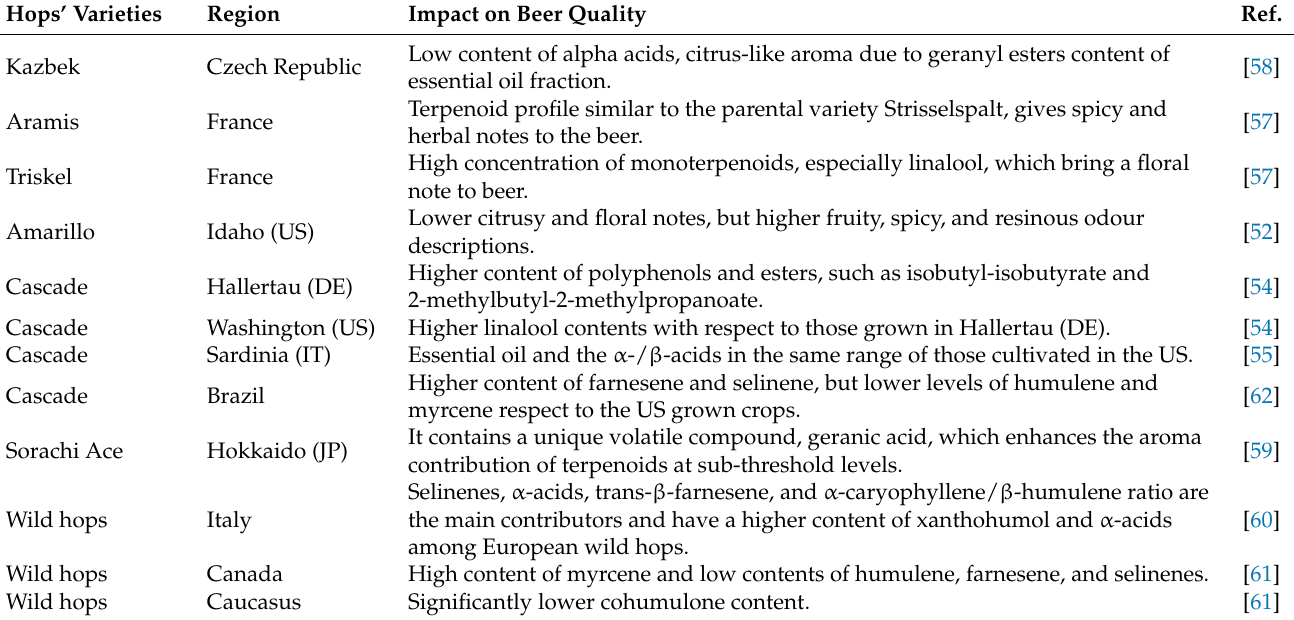
Table 2. Cultivars, origins, and impact of hops recently investigated for their brewing potential. Hops’ Varieties Region Impact on Beer Quality